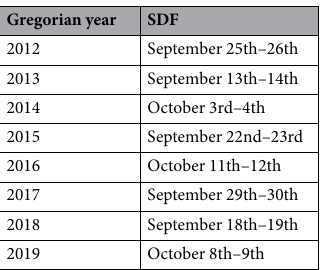
Table 1. Gregorian days of Yom Kippur fasting (i.e.: single day fasting, SDF) between 2012 and